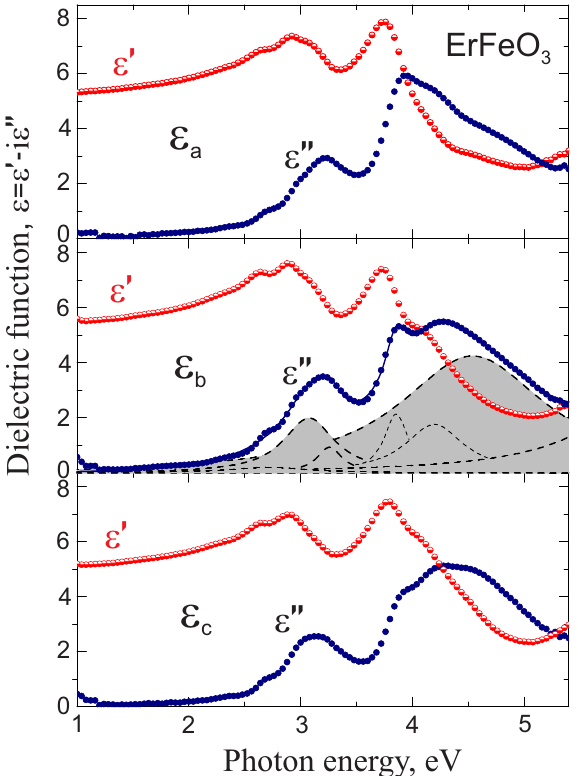
Figure 2. (Color online) The dielectric function spectra in ErFeO 3 orthoferrite for three main polariza- tions. The Lorentzian fitting is marked by dotted curves and filling. Adapted from